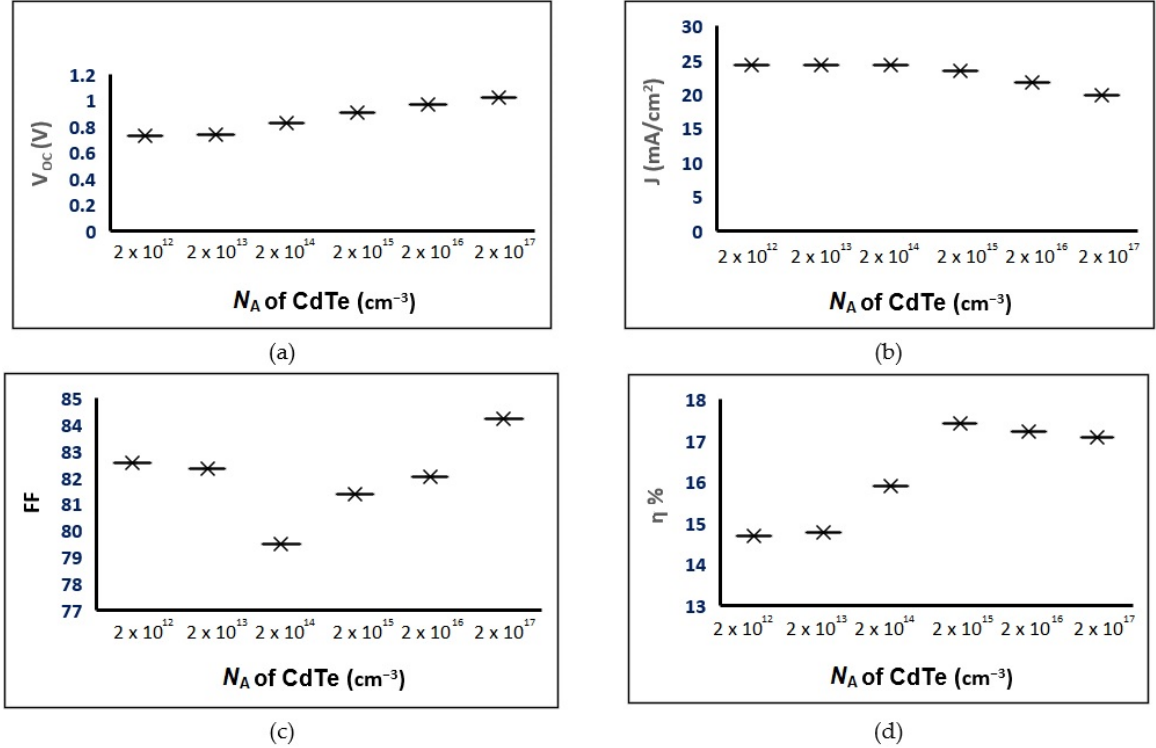
Figure 4. The simulated electrical performance parameters as a function of the acceptor charge carrier concentration ( N A ): ( a ) V OC , ( b ) J SC, ( c ) FF , ( d ) η %.